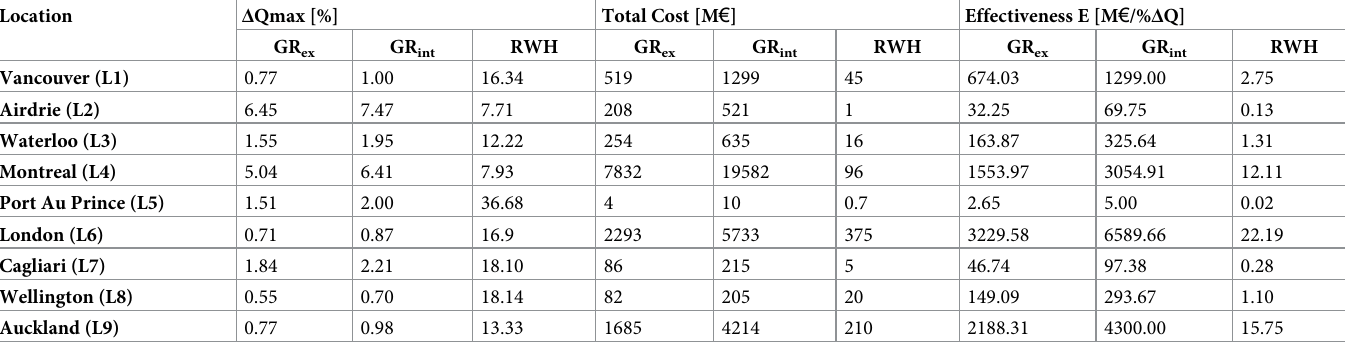
Table 1. Cost-efficiency summary for each location. Maximum discharge reduction (as a percentage of initial runoff), total cost of the installation of the different solu- tions in the entire city and effectiveness (ratio between total costs and maximum discharge reduction). Location Δ Qmax